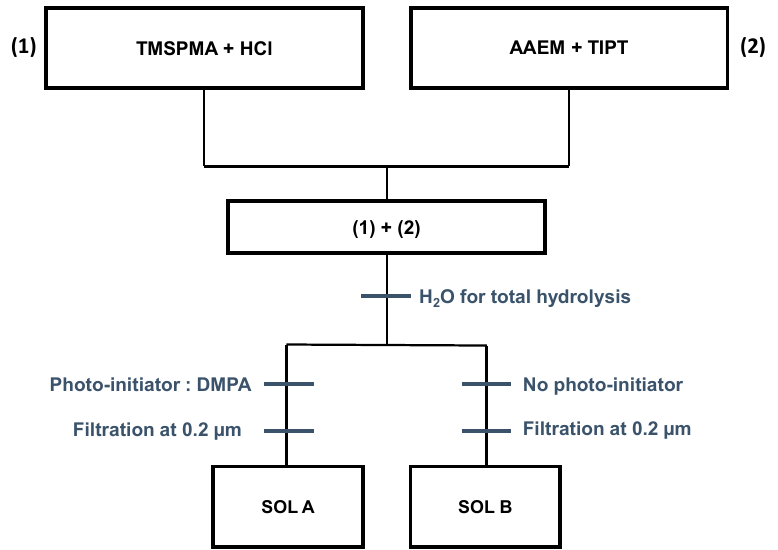
Figure 1. Preparation of TiO 2 -SiO 2 sol–gel. Sol A represents the sol–gel containing the UV photo-initiator (2,2-dimethoxy-2-phenylacetophenone). Sol B was prepared following the same procedure but without the photo-initiator.